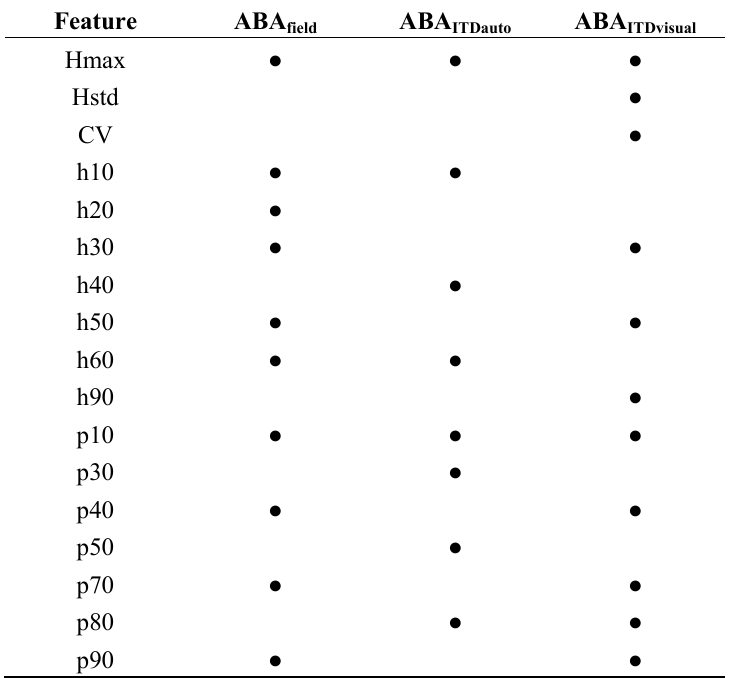
Table 4. Statistical LiDAR features used in k-MSN imputations.